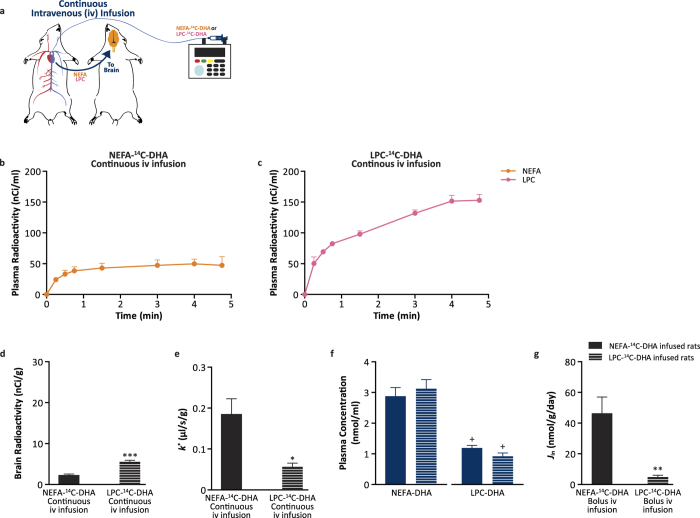
Plasma LPC-DHA and NEFA-DHA contribution to brain total DHA uptake via continuous iv infusion kinetic model.(a) Schematic diagram of continuous iv infusion kinetic modeling. (b,c) Plasma curve from continuous iv infusion of low-dose (10 μCi) NEFA-14C-DHA or LPC-14C-DHA over 5 minutes (n = 4 each). (d) Brain radioactivity of total phospholipids from rats iv infused with NEFA-14C-DHA or LPC-14C-DHA. (e) The uptake incorporation coefficient (k*) into brain total phospholipids from rats continuously iv infused with NEFA-14C-DHA or LPC-14C-DHA. (f) The baseline plasma concentration of total NEFA-DHA and LPC-DHA prior to NEFA-14C-DHA or LPC-14C-DHA continuous iv infusion. (g) The net incorporation rate of DHA (Jin) into brain total phospholipids from rats continuously iv infused with NEFA-14C-DHA or LPC-14C-DHA. All data are expressed as mean ± SEM. *P < 0.05, **P < 0.01 and ***P < 0.001 indicate significant difference from NEFA-14C-DHA infused rats using Students’ t-test. +P < 0.01 indicates significant difference between plasma LPC-DHA and NEFA-DHA concentration. See Fig. 2 for abbreviations.